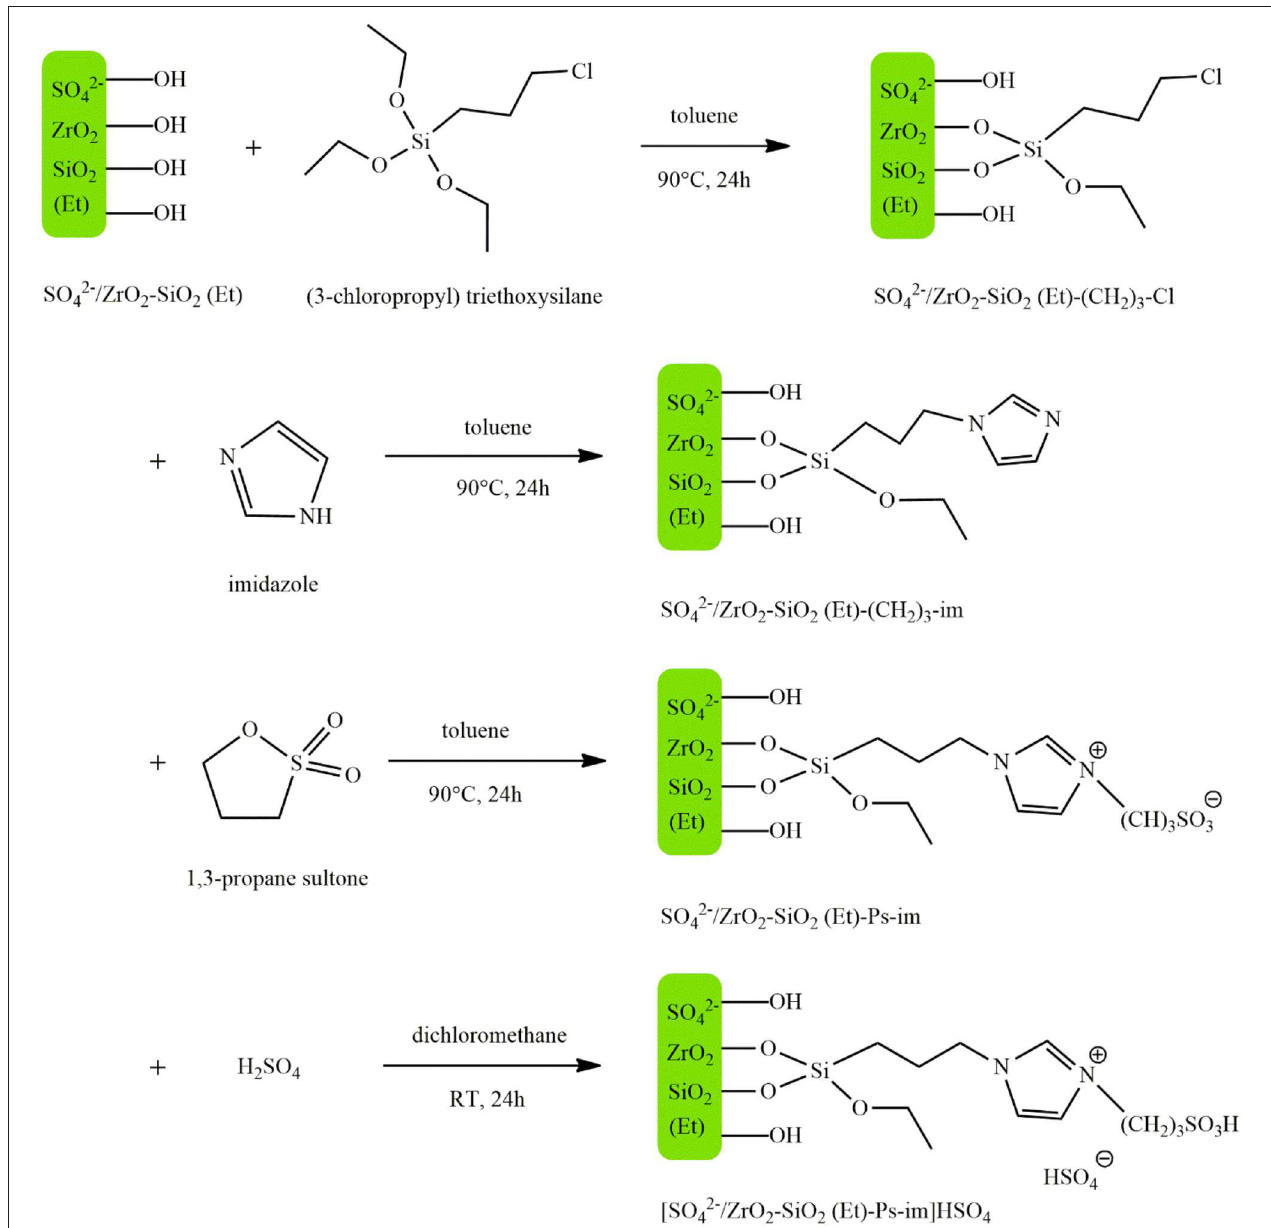
FIGURE 2 | The synthesis process of [SO 2 − 4 /ZrO 2 -SiO 2 (Et)-Ps-im]HSO 4 [Redrawn from Fan et al.